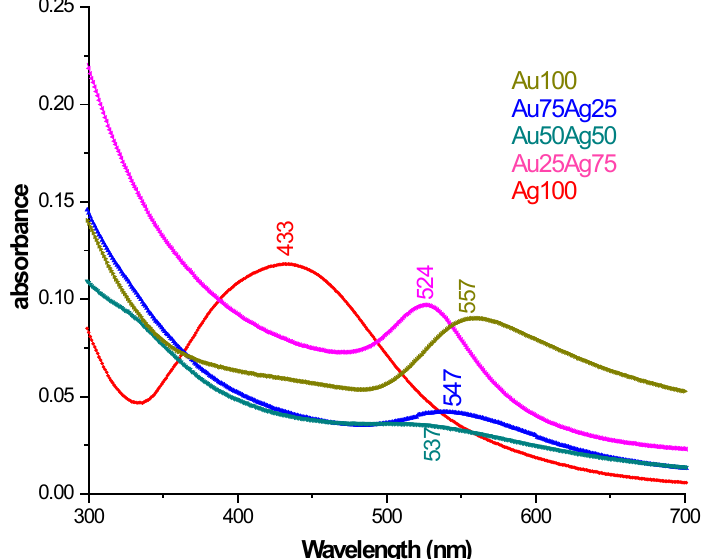
Fig. 1. UV-Vis absorption spectra of Au-Ag alloy NPs synthesized with different Au-Ag molar